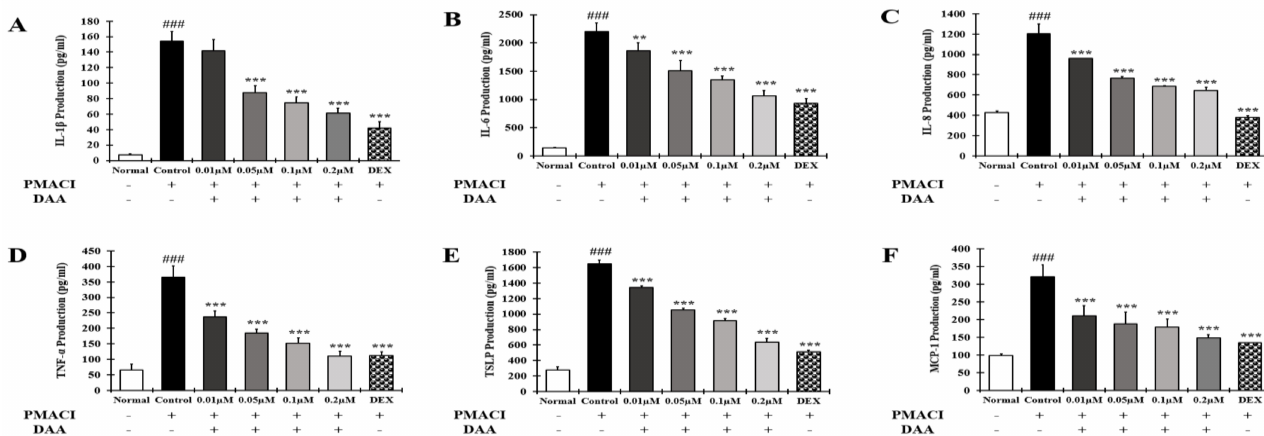
Figure 11. Effect of DAA on AD-related cytokines and chemokines secreted by HMC-1cells. The level of IL-1 β ( A ), IL-6 ( B ), IL-8 ( C ), TNF- α ( D ), TSLP ( E ), and MCP-1 ( F ) in the supernatant of HMC-1 cells was determined by ELISA. The results are expressed as the mean ± SD (n = 4). ### p < 0.001 vs. normal; ** p < 0.01 and *** p < 0.001 vs. control; DAA was used at 0.01 µ M, 0.05 µ M, 0.1 µ M, and 0.2 µ M. DEX, the positive control, was used at 0.1 µ M.